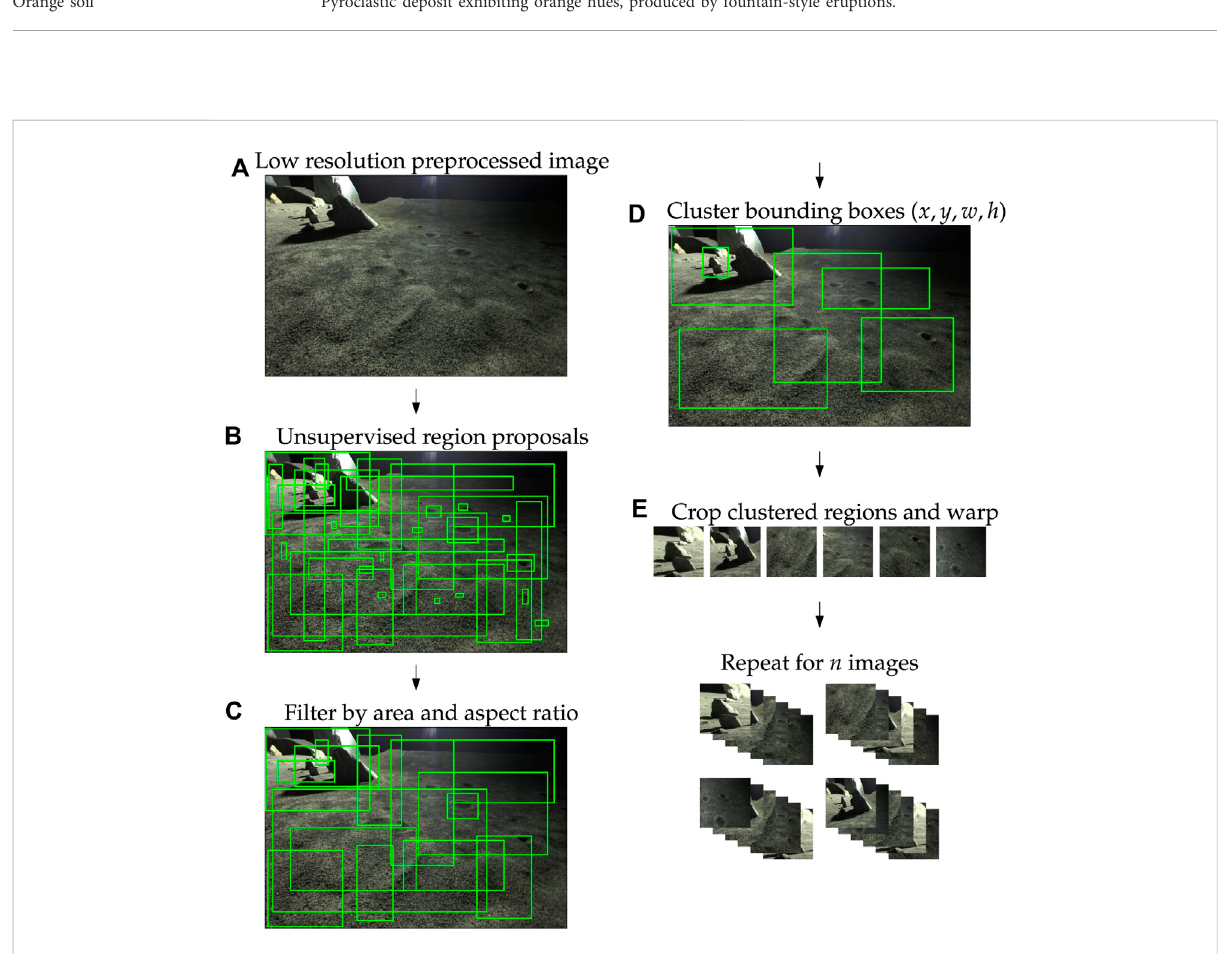
FIGURE 2 (A – E) Composition of the region proposal system used for novel region